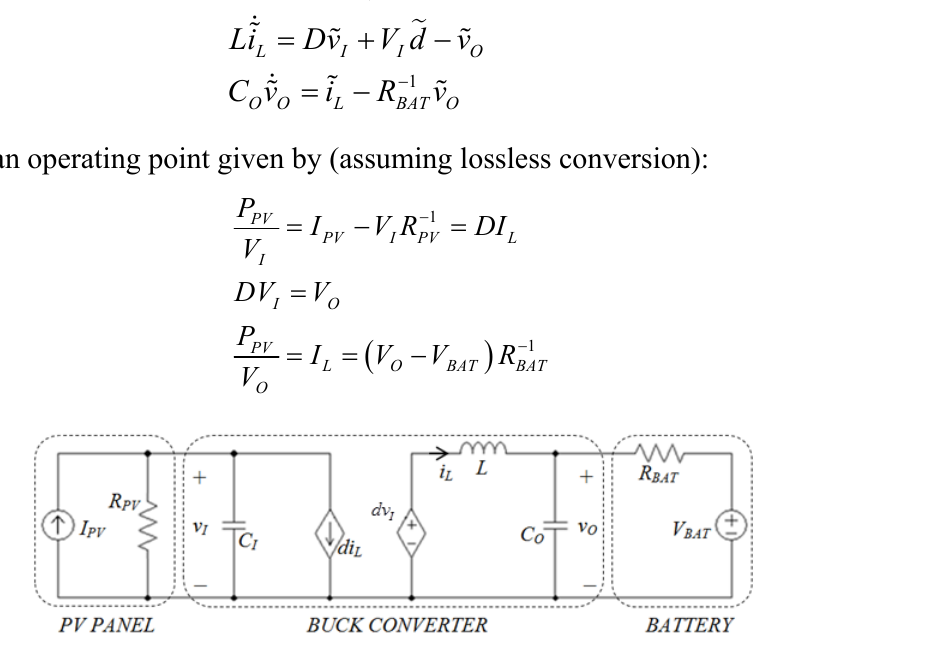
Figure 9. Averaged system